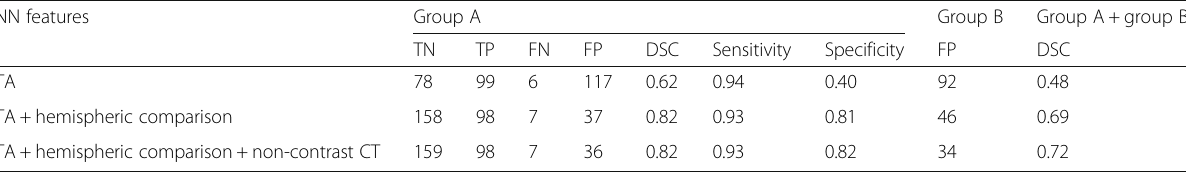
Table 2 Total number of infarct positive brain regions in 15 test subjects in group A and 15 non-infarcted test subjects in group B compared with radiologist evaluation